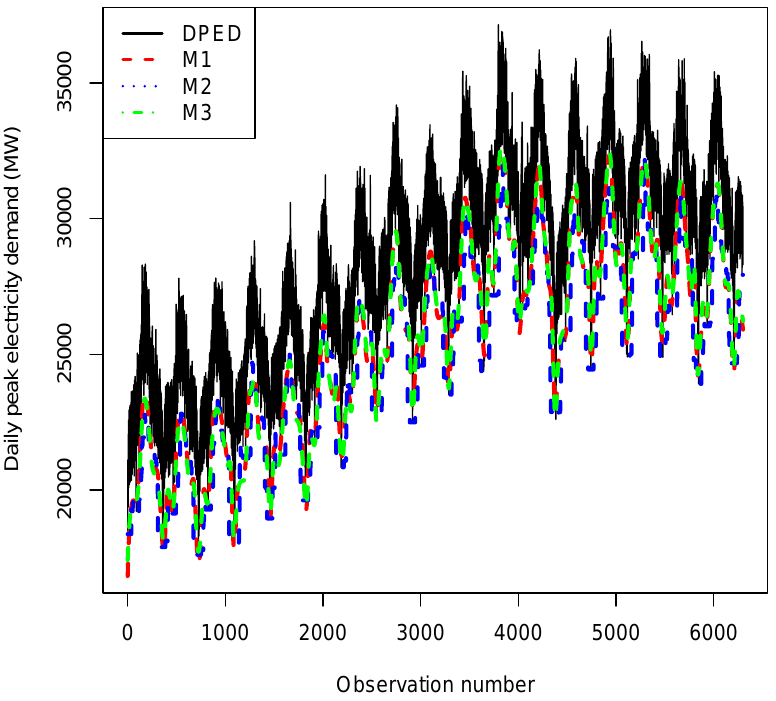
Figure 5. DPED superimposed with the 0.01 quantiles from the M1, M2 and M3 models. Figures 6–8, respectively, show three box plots of the 0.99, 0.999 and 0.9999 quantiles with the AQR, EM and NLQR models. The box plots for the EM model have shorter left tails and longer right tails compared to the other two models, AQR and NLQR, respectively. The medians of the AQR and NLQR models are all at the same level; however, their box plots show very different distributions for the DPED